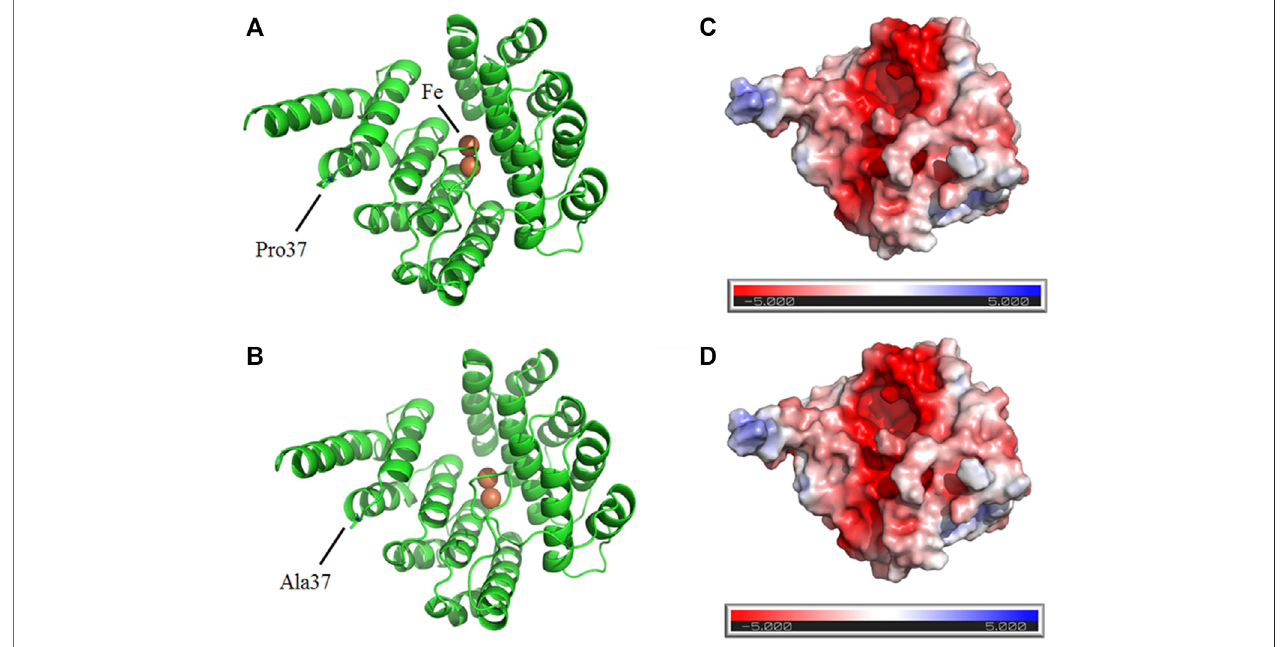
FIGURE 4 | Predicted structures of wild (A) and mutant (B) DOHH proteins show the surface location Pro37 and Ala37, respectively. The electrostatic analysis of wild-type (C) and mutant (D) DOHH protein.